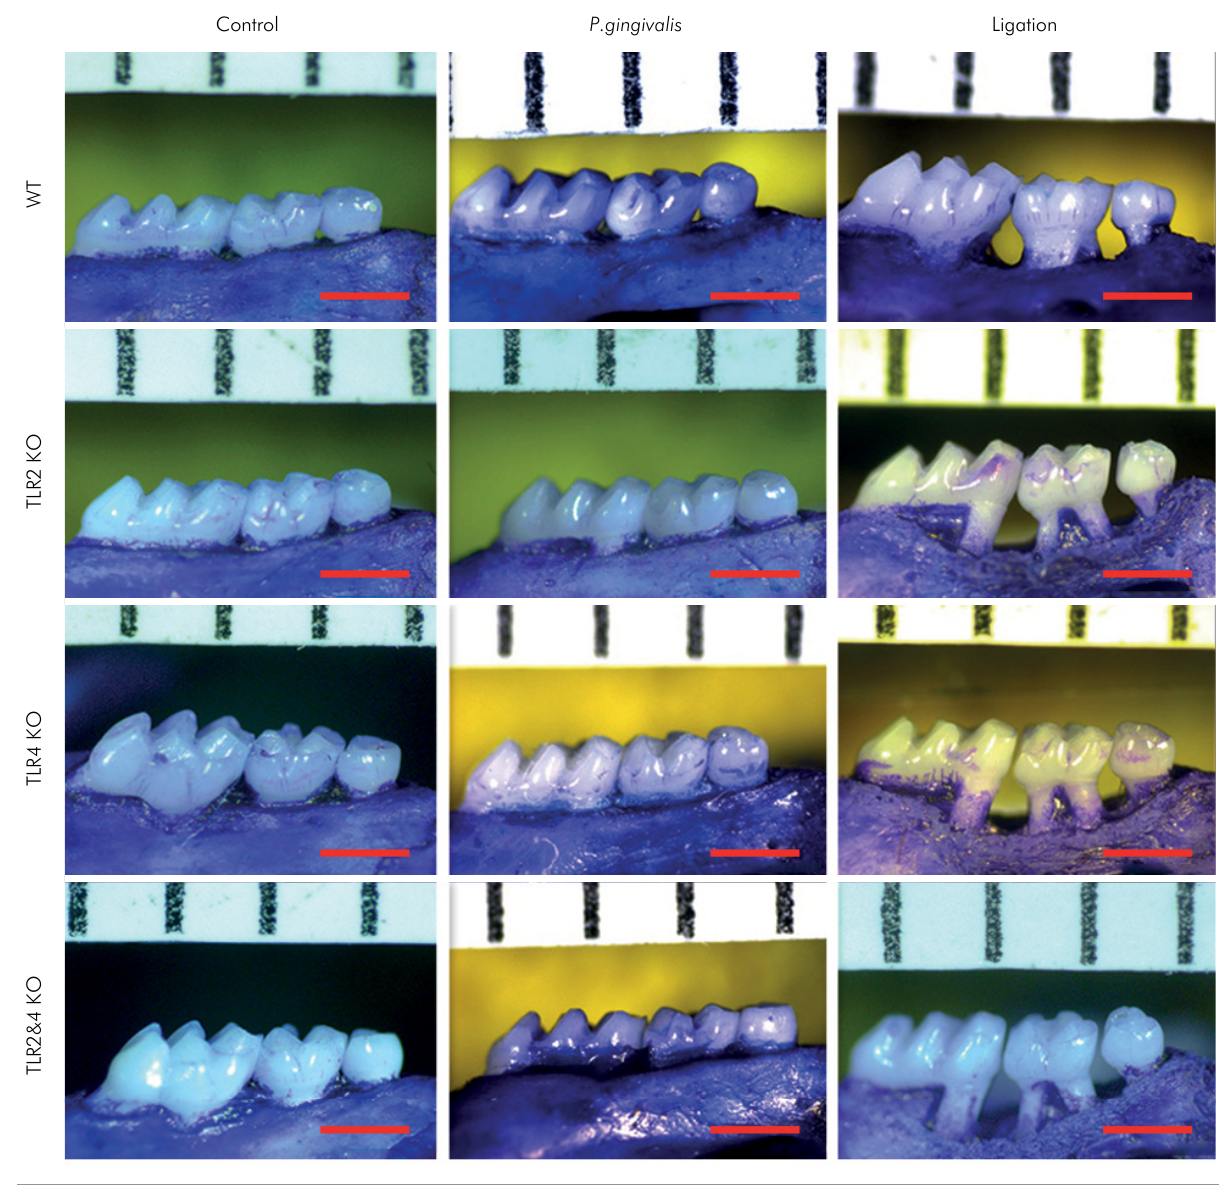
Figure 1. Maxillary images of P. gingivalis -induced and ligation-induced experimental periodontitis in WT, TLR2 KO, TLR4 KO, and TLR2&4 KO mice. Experimental periodontitis was induced by the application of live P. gingivalis in the sulcus of maxillary second molars or by silk ligatures wrapped around maxillary second molars on both sides over a 14-day period in WT, TLR2 KO, TLR4 KO, and TLR2&4 KO mice. Maxillae were collected on day 14 and de-fleshed by a Dermestid beetle colony. After being bleached with 3% hydrogen peroxide, the bone was stained with 1% toluidine blue. The alveolar bone resorption areas around maxillary secondary molars were viewed by microscopy (30X) for the control group, the P. gingivalis infection group, and the ligation group of WT, TLR2 KO, TLR4 KO, and TLR2&4 KO mice, respectively (scale bar, 1